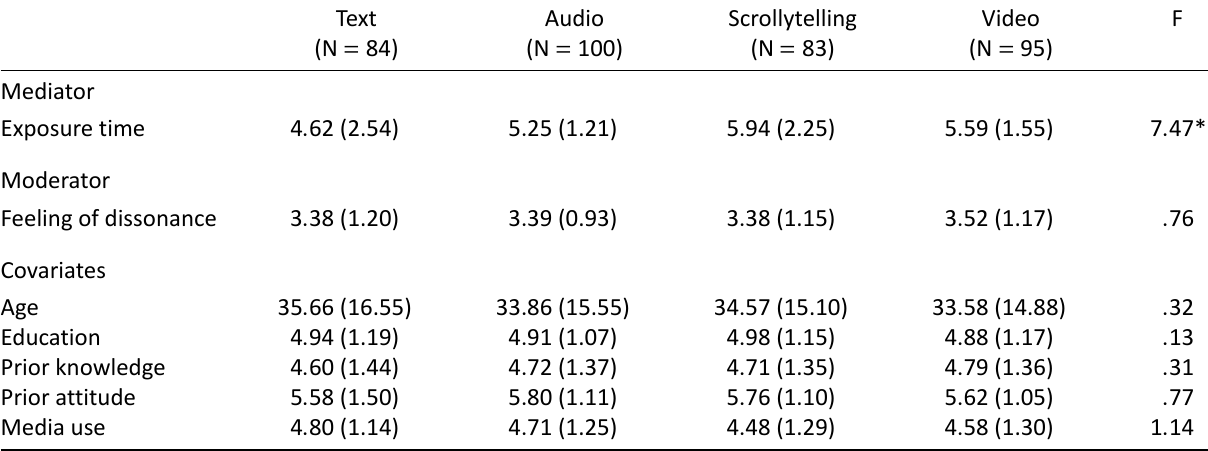
Table 1. Summary of mean comparisons, standard deviations and